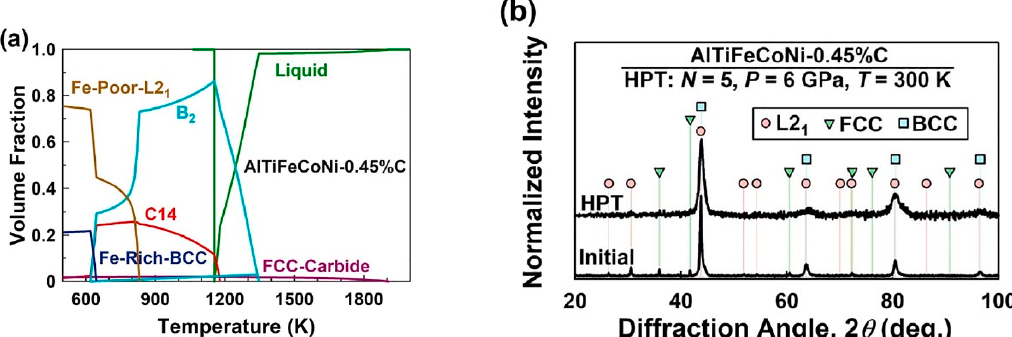
Figure 10. ( a ) Phase diagram calculated by CALPHAD program, and ( b ) XRD profiles of AlTi- FeCoNi-0.45%C before and after HPT processing. Reprinted with permission from Ref. [129]. Copyright 2021 Elsevier.